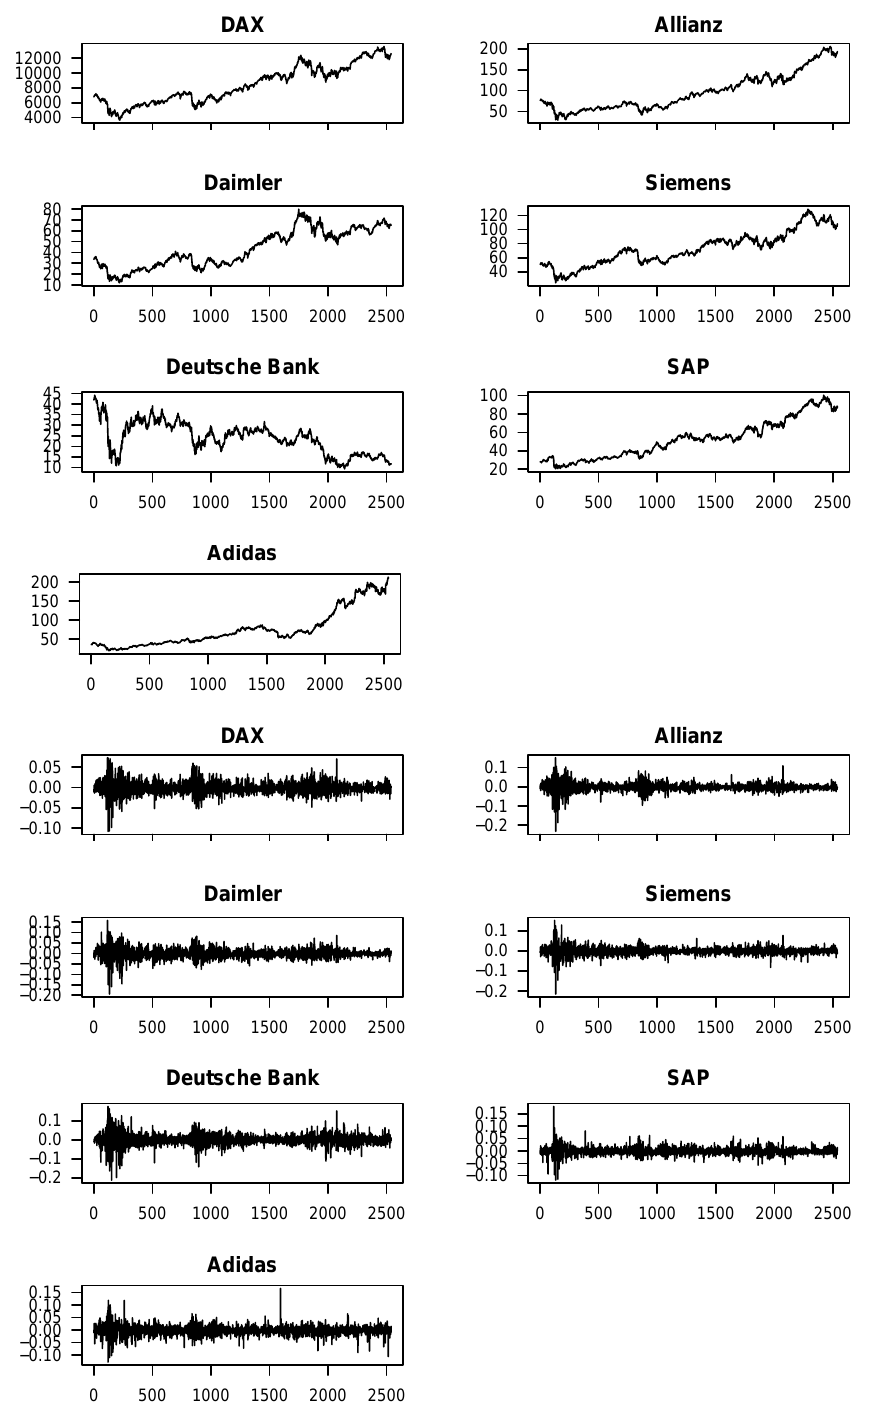
Figure 1: Daily adjusted close data resp. the log-returns of the underlying assets from 23/04/2008 to 20/04/2018; x -axis: n -th trading day beginning with 23/04/2008; y -axis: adjusted closing price resp. log-return of the underlying